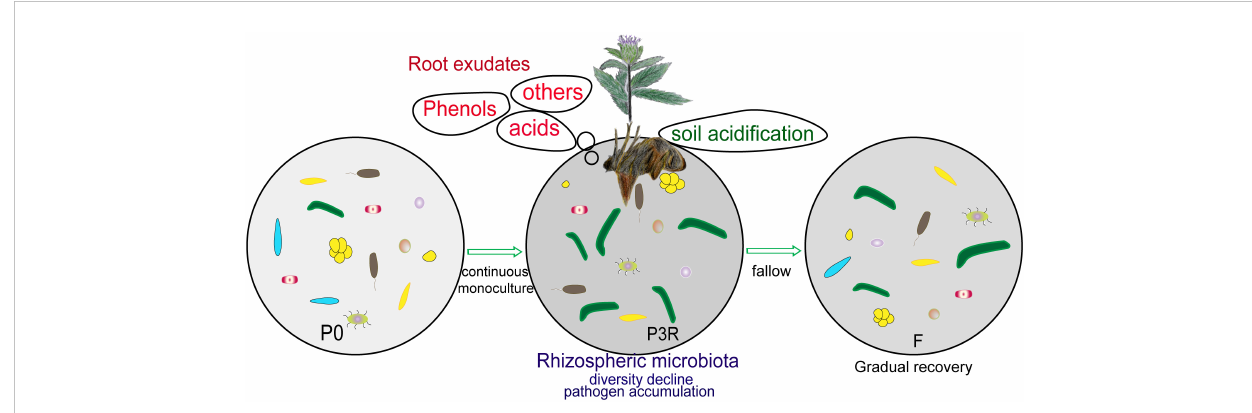
FIGURE 7 Schematics of natural fallow alleviating the deterioration of soil caused by the continuous monoculture of A. lancea . P0, control soil; F, one-year fallow soil; P3R, Rhizosphere soil after three years consecutive